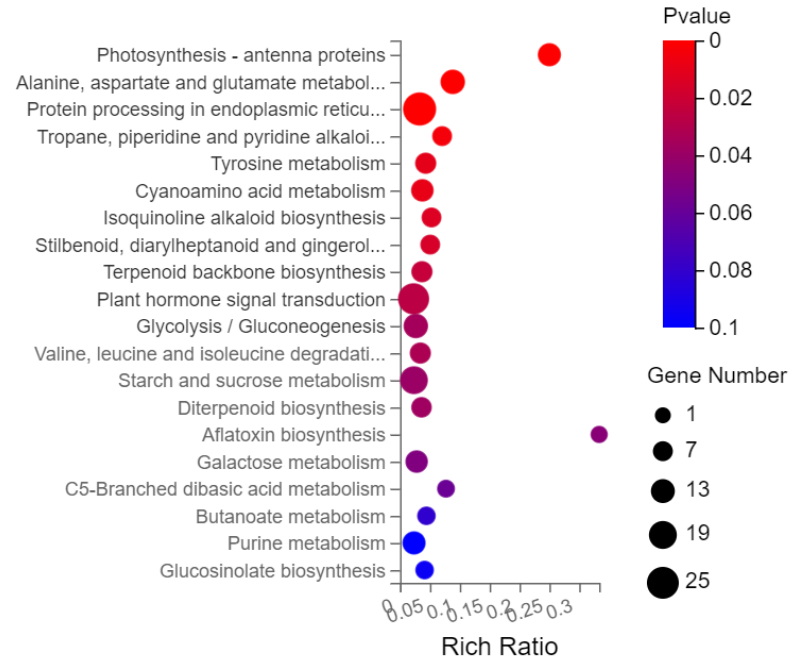
Figure 9. Bubble diagram of KEGG pathway enrichment of differentially expressed genes.